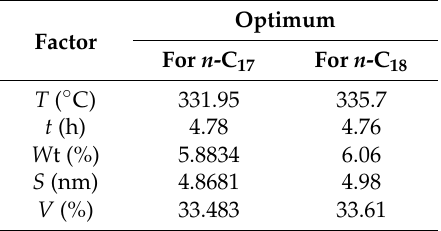
Table 5. Combination of factor levels that maximize the yield of n -C 17 and n -C 18